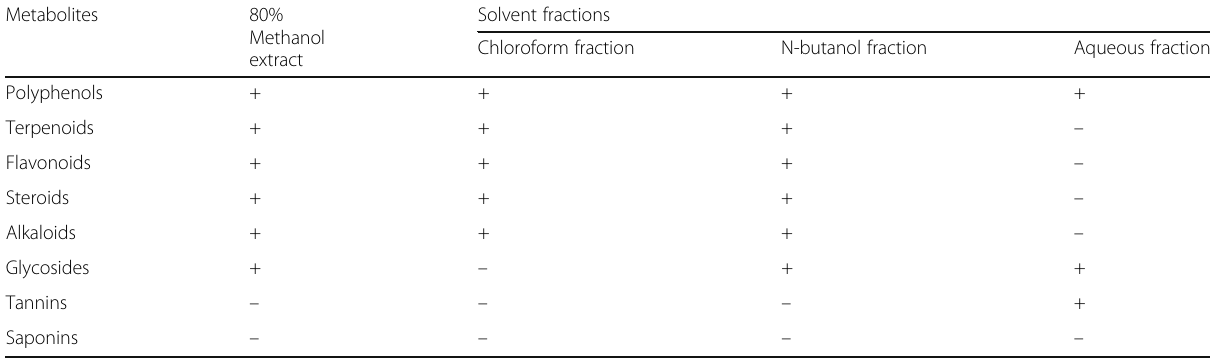
Table 9 Preliminary phytochemical screening of 80% methanol extract and solvent fractions of the leaves of Olea europaea